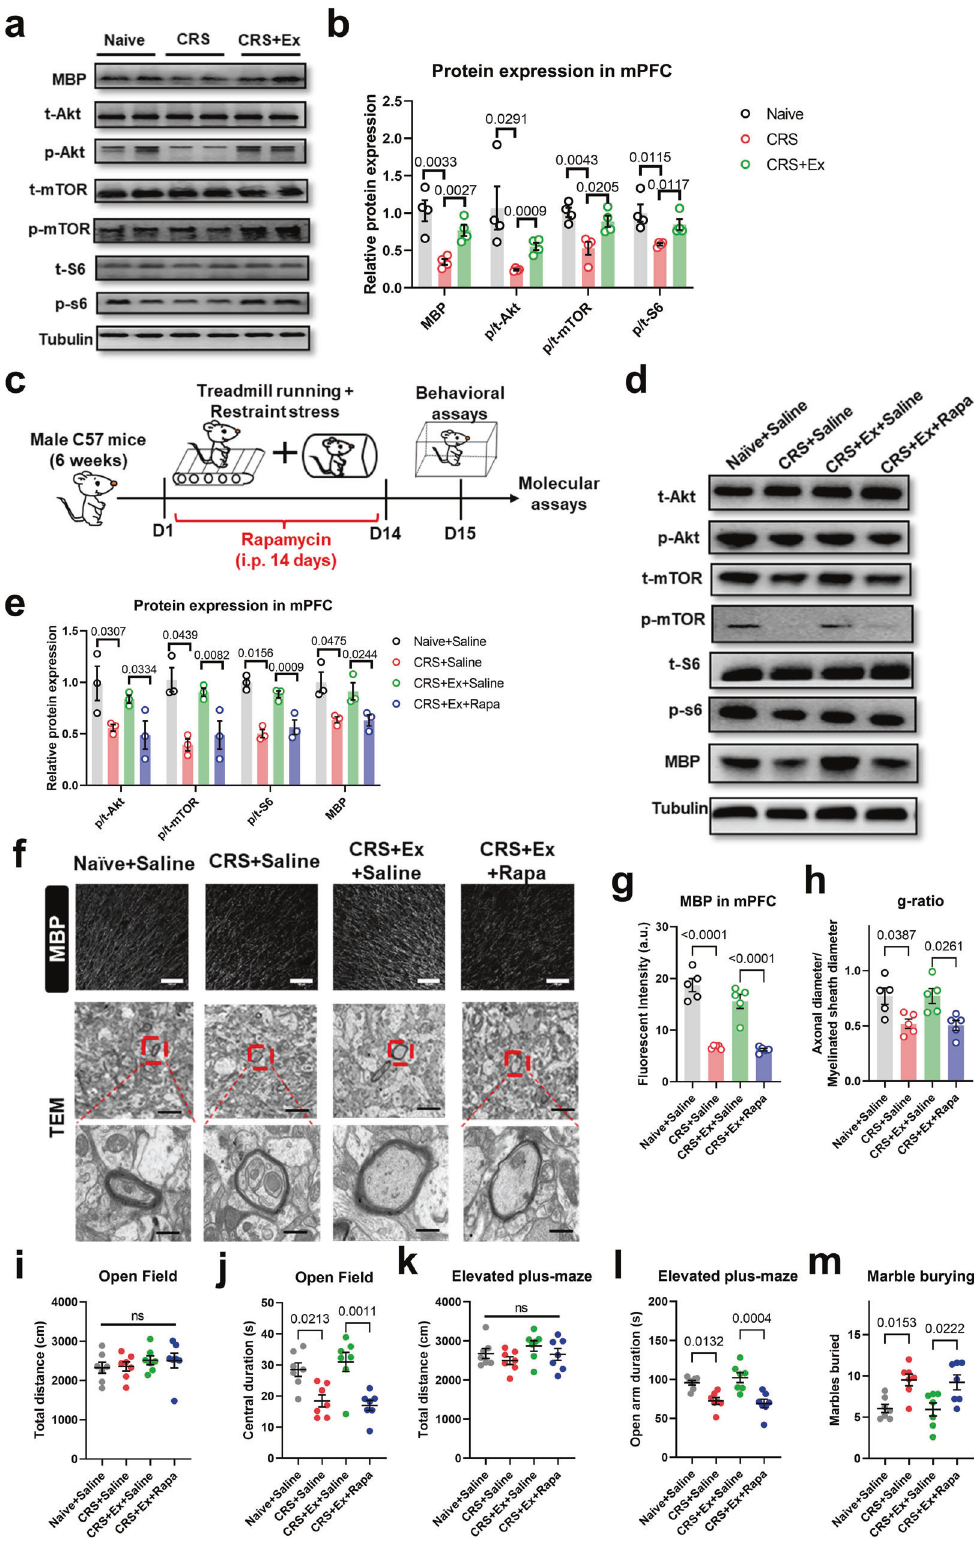
expressional pro fi les in mPFC (Fig. 6a), we identi fi ed a total of 200 proteins that were signi fi cantly regulated by both CRS and exercise intervention (Fig. 6b). Further analysis discovered that the Fmr1 gene, which encodes Fragile X mental retardation protein (FMRP),